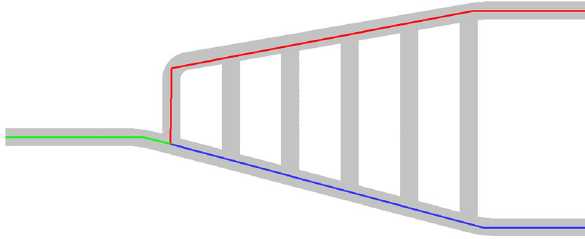
Fig. 5 Travel flow path through the